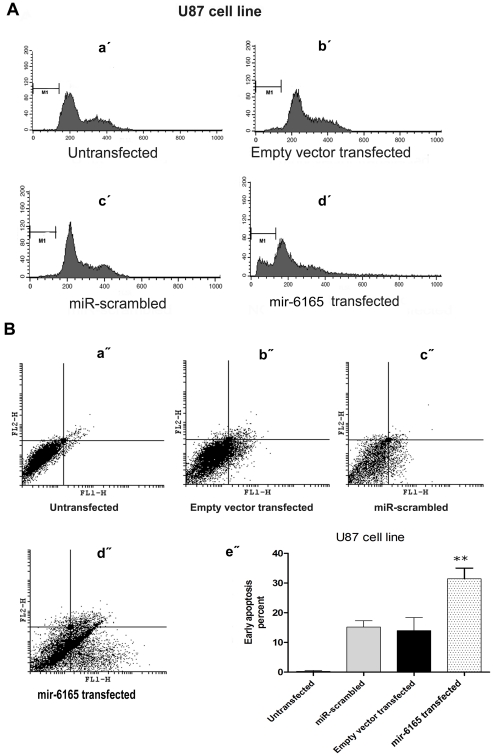
mir-6165 overexpression in U87 cell line induces apoptosis.A) PI staining of U87 cells 34 hours post transfection was done to investigate the effect of mir-6165 on cell cycle. A dramatic change was observable toward sub-G1 stage in the cells overexpressing mir-6165 compared to negative controls (a′- d′).B) Annexin-PI staining of the U87 cells overexpressing mir-6165 shows, the most of the cells have entered early apoptosis stage compared to negative control and the result is consistent with PI staining in the previous section (a″- d″). The gate setting distinguished between living (bottom left), necrotic (top left), early apoptotic (bottom right), and late apoptotic (top right) cells. Repeated Measures ANOVA analysis shows that the changes observed in flow cytometry of U87 cells is extremely significant (p<0.05) between negative controls and the cells overexpressing mir-6165 (e″).